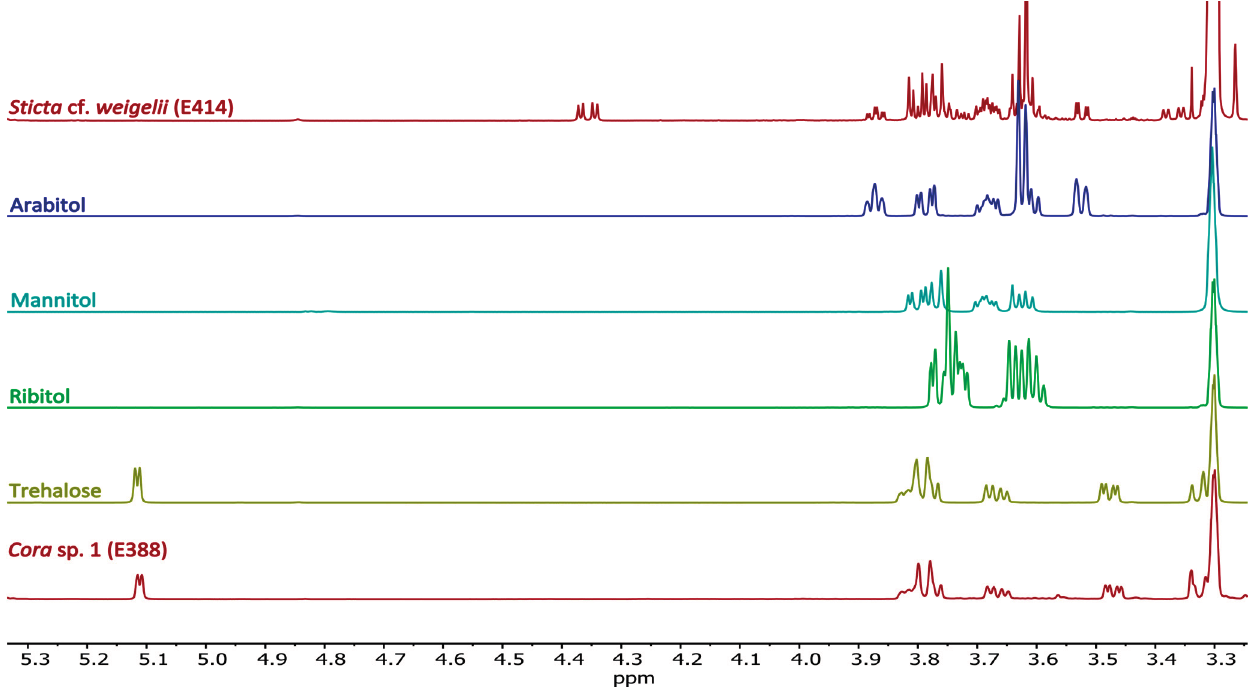
Figure 5. 1 H-NMR spectra of different reference compounds in comparison with methanolic lichen extracts of Sticta and Cora